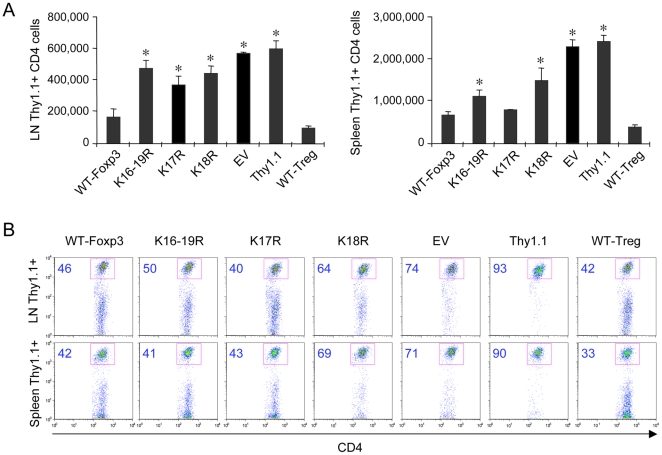
Foxp3 mutants impair Treg function in vivo.(A) 1×106 Thy1.1+ CD4+CD25− T cells were co-transferred with 1×106 Thy1.2+ CD4+ T cells transduced with WT Foxp3, K16-19R, K17R, K18R or EV, or with purified normal B6 Treg cells, into Rag1−/− mice. At 7 d post-transfer, single-cell suspensions from lymph node or spleen samples were stained for FACS analyses; the numbers (A) or percentages (B) of CD4+ Thy1.1+ cells are shown. Results are representative of 2 independent experiments, and *p<0.05 compared to WT Foxp3.